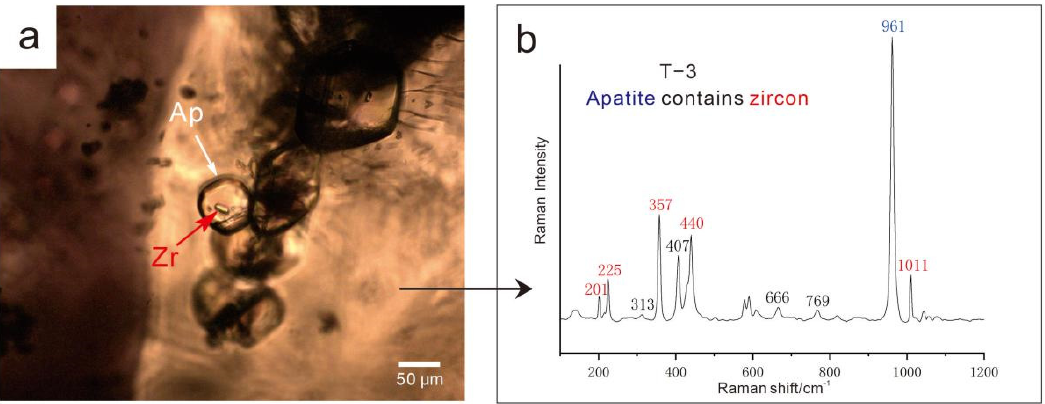
Figure 8. ( a ) Zircon inclusion in Tajikistani spinel (T − 3) and ( b ) its (T − 3) Raman spectrum. The spinels from both Myanmar (M-8, M-10) and Tajikistan (T-2) contained carbonate